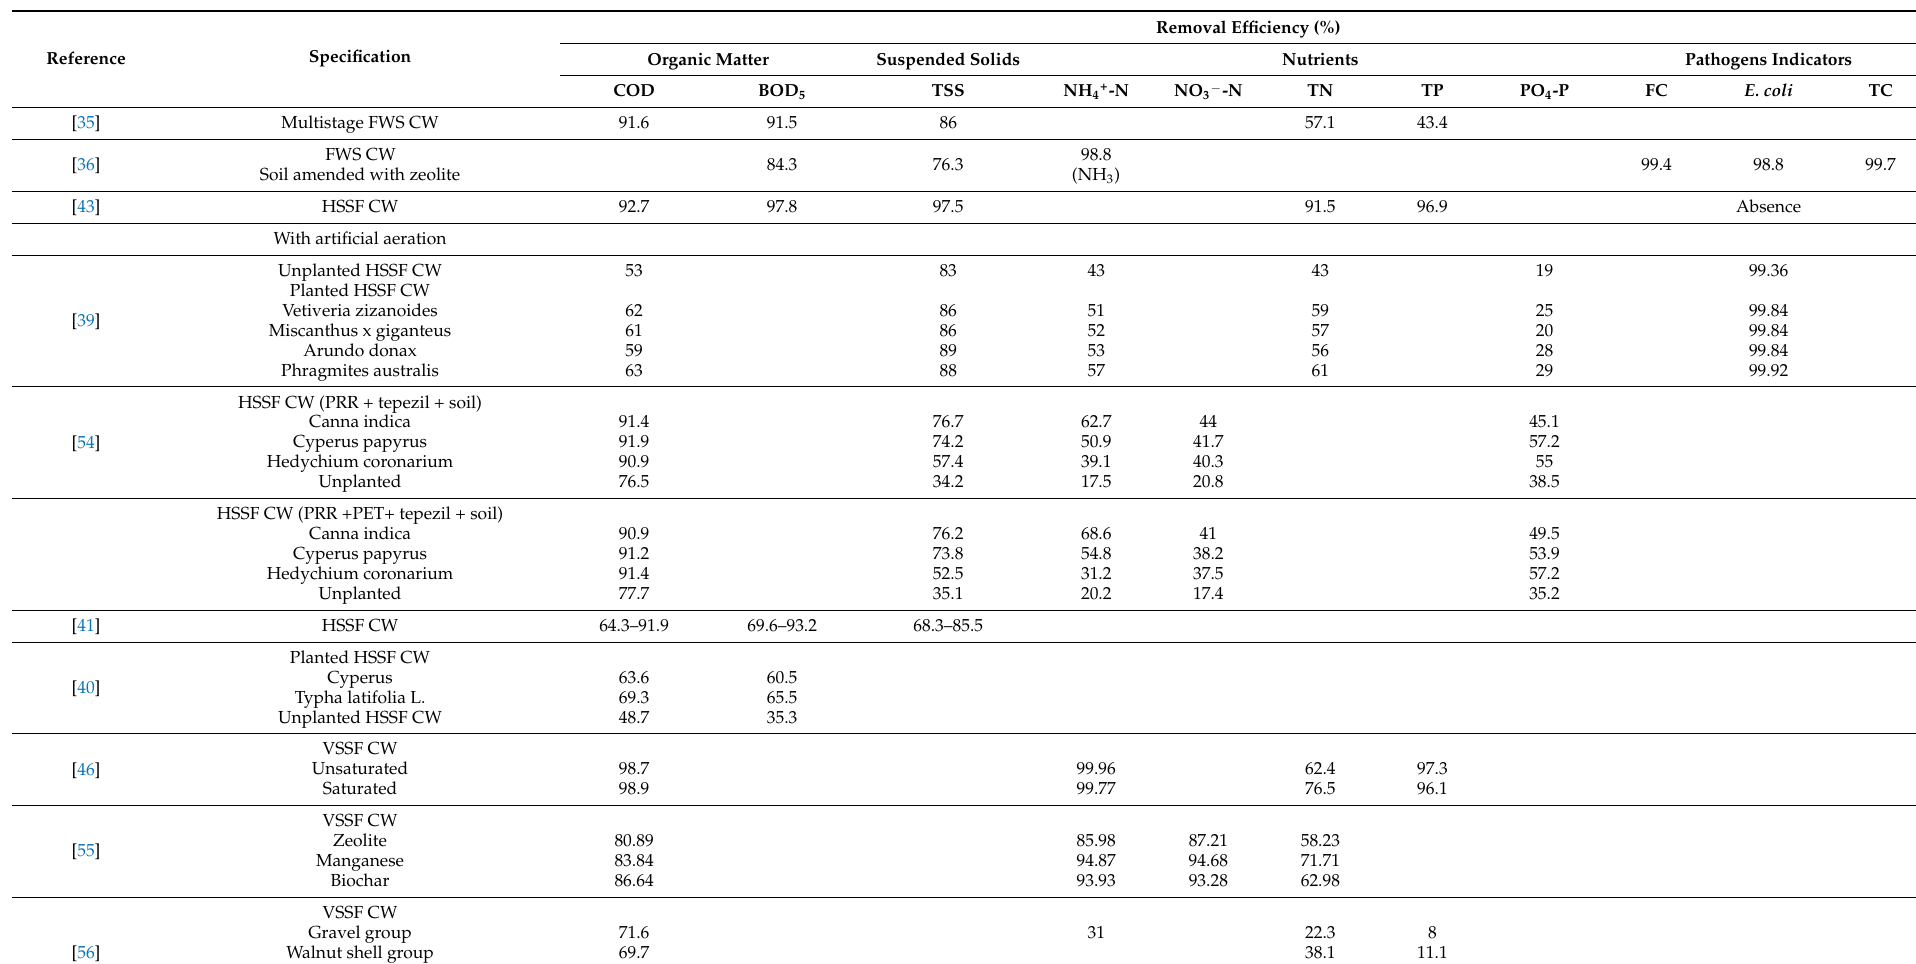
Table 2. Removal efficiency of different pollutants in FWS, HSSF, VSSF, and hybrid constructed